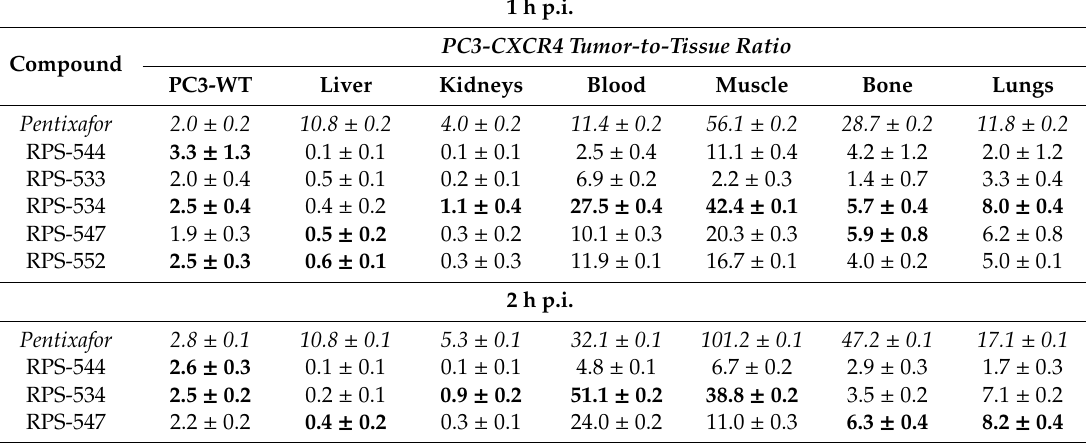
Table 3. Tumor-to-tissue ratios for candidate CXCR4 ligands at 1 h p.i. (top) and 2 h p.i. (bottom). [ 18 F]RPS-544 [24] and [ 68 Ga]Pentixafor are included for comparison. The highest values for the [ 18 F]fluorinated compounds are shown in bold for